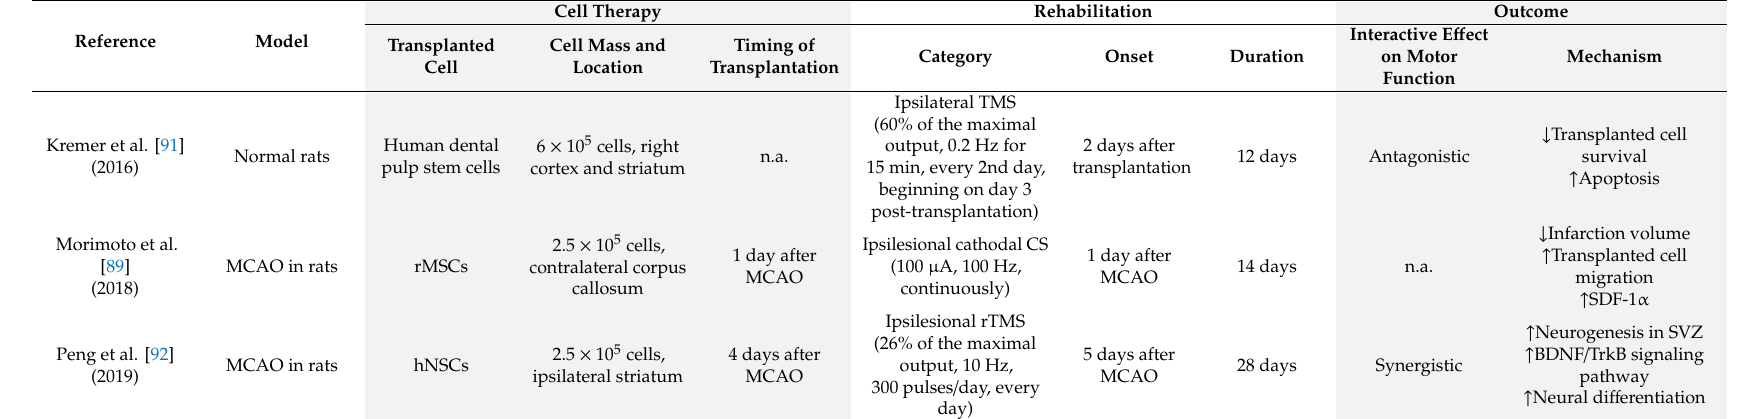
Table 2. Summary of therapeutic e ff ects of combining cell therapy and brain stimulation on motor function in animal